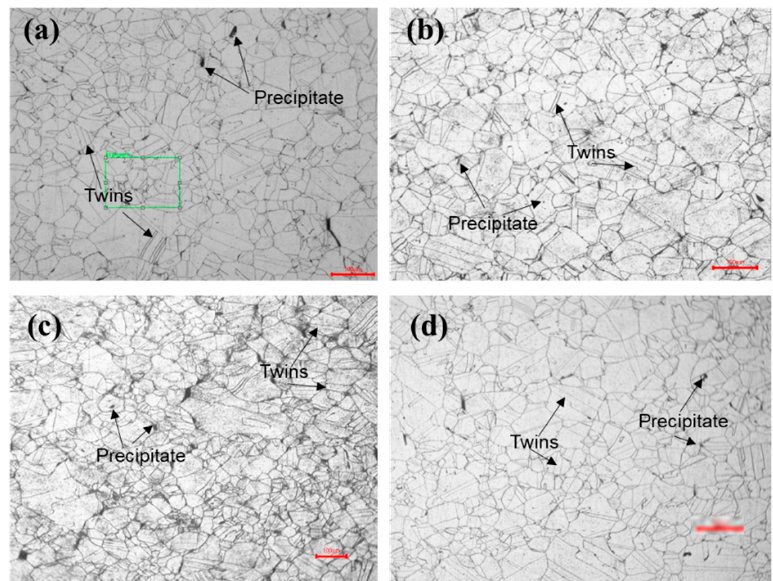
Figure 17. Microstructures of 253 MA ASS at annealing times of ( a ) 0; ( b ) 900; ( c ) 1800; ( d ) 3600 s at gauge length after creep rupture test with a 100× magnification.